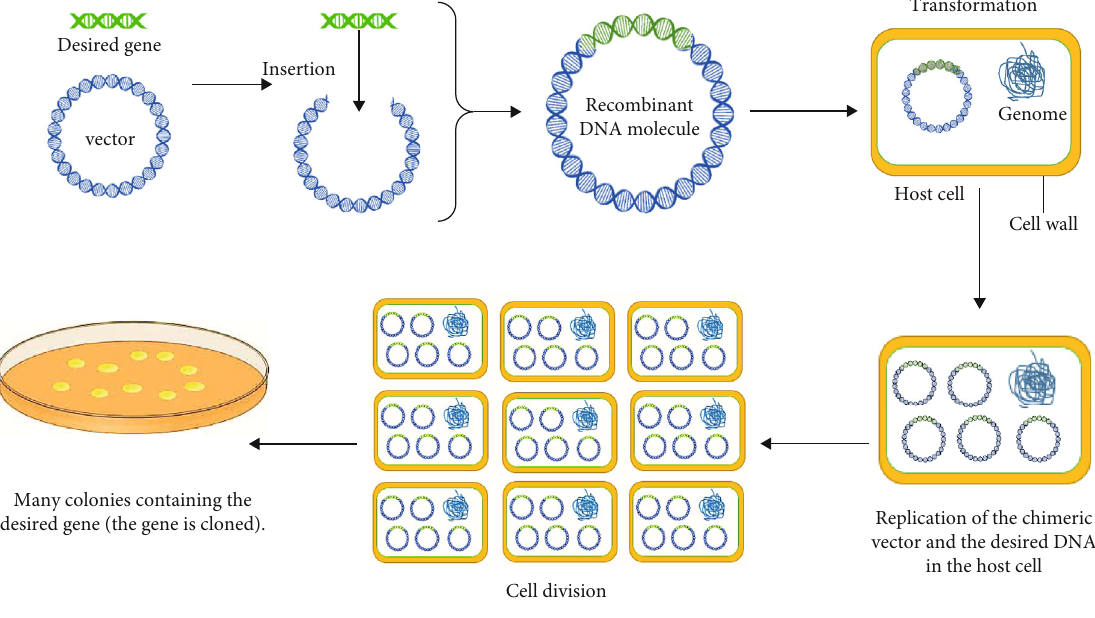
Figure 1: Molecular cloning